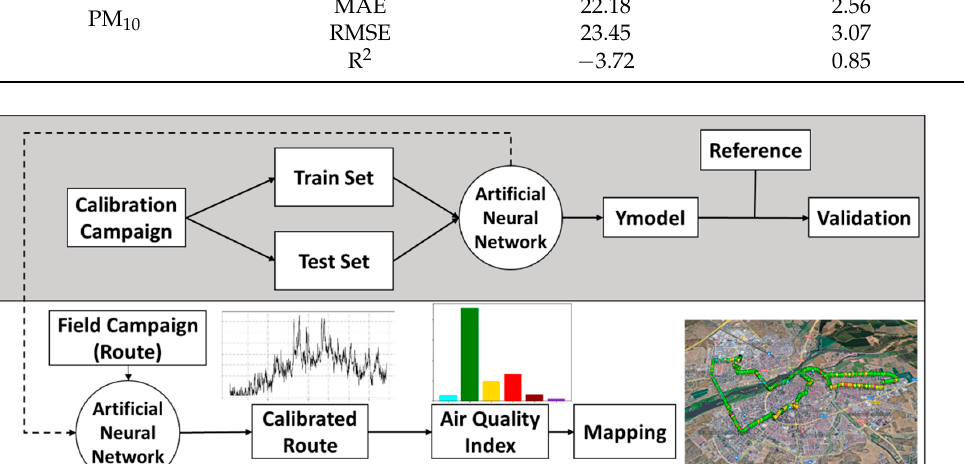
Figure 8. Calibration and measurement process flowchart.